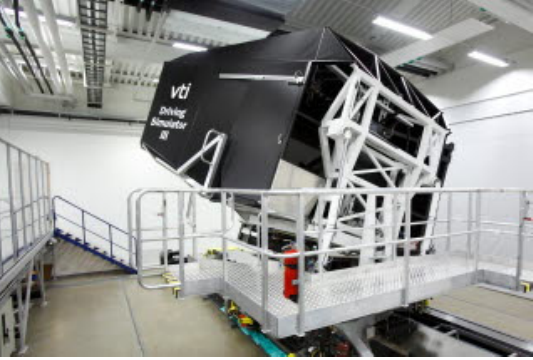
Figure 1. VTI Driving Simulator III (https://www.vti.se/en/research/vehicle-technology-and-driving-simulation/driving-simulation/simulator-facilities) (Accessed date: 26 November-2021) .